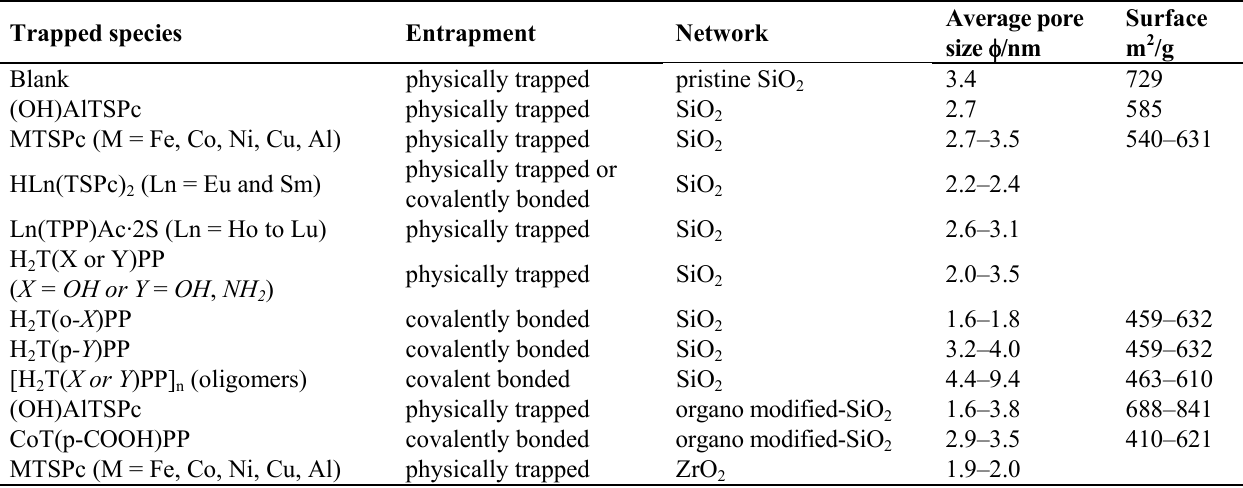
Table 1. Textural properties, evaluated by N adsorption, of xerogels with diverse tetrapyrrolic 2 macrocyclic species trapped or bonded to the pore network. The blank is a specimen synthesized from TEOS without including trapped or bonded macrocyclic